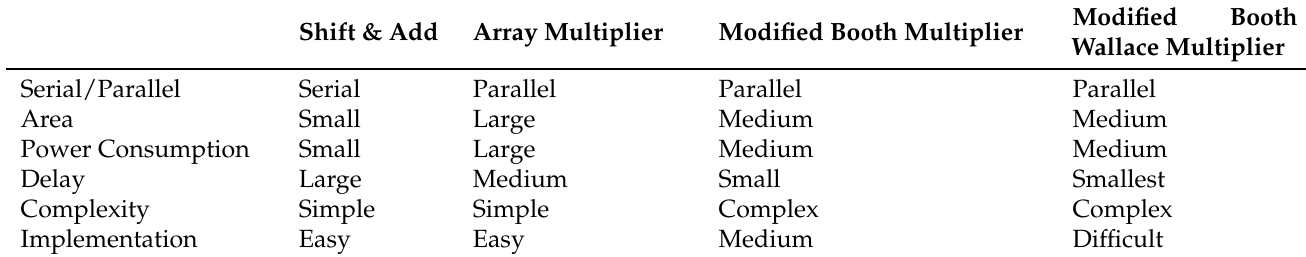
Table 1. Multiplier Circuit Comparison